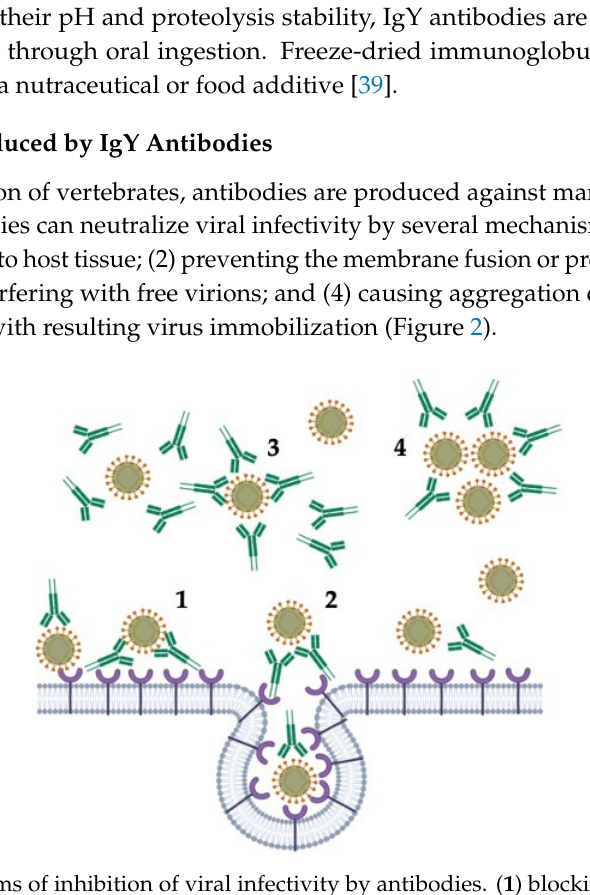
Figure 2. Mechanisms of inhibition of viral infectivity by antibodies. ( 1 ) blocking the attachment of the virus to host tissue; ( 2 ) preventing the membrane fusion or promoting the detachment of bound virus; ( 3 ) interfering with free virions; and ( 4 ) causing aggregation of virus particles with resulting virus immobilization (Created with